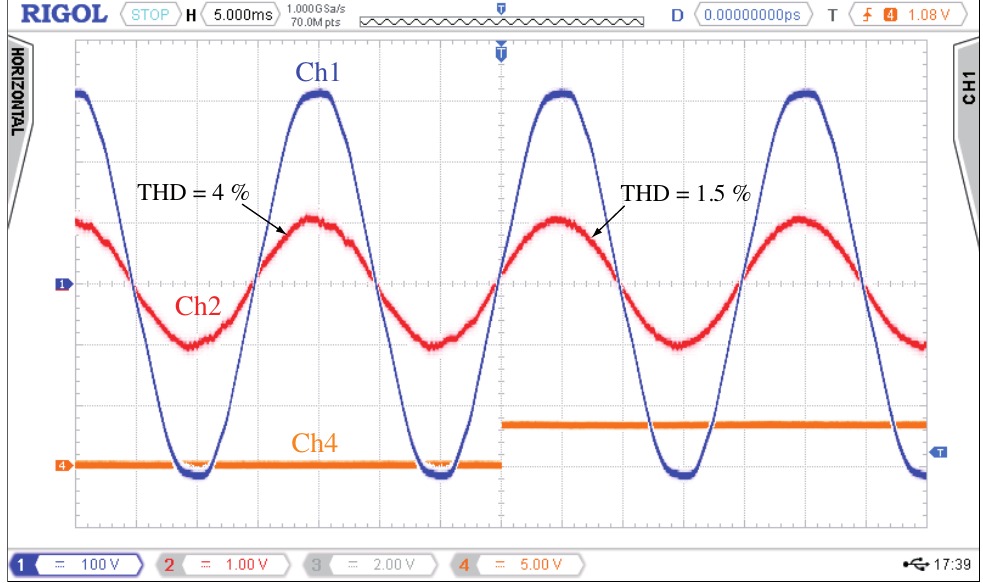
Figure 13. Activation–deactivation of the CE with IPCC control at half nominal power. Ch1: grid voltage (100 V/div); Ch2: grid current (10 A/div); Ch4: CE on/off signal (0 = off, 1 =